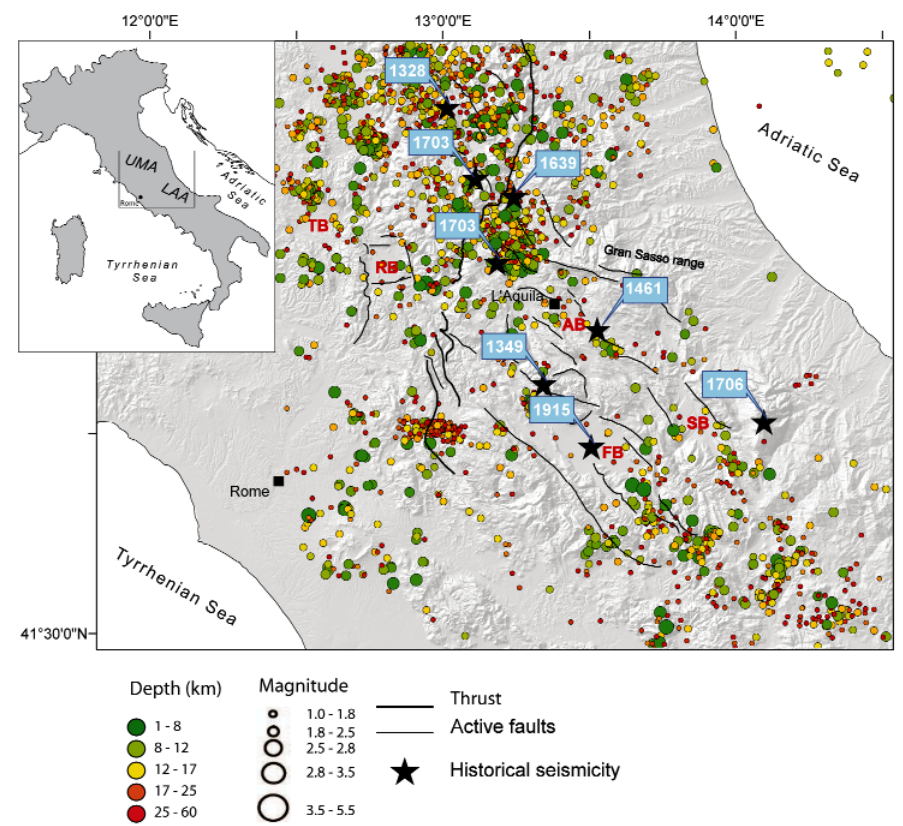
Figure 1. Geological settings of the Umbria-Marche Apennines (UMA) and the Lazio-Abruzzo Apennines (LAA). The main fault systems and intramontane basins are shown (red text): TB, Terni basin; RB, Rieti basin; AB, L'Aquila basin; FB, Fucino basin; SB, Sulmona basin. The instrumental (1978-2008) and historical (I>10) (CPTI04) (http://emidius.mi.ingv.it/CPTI04) seismicity distributions are shown. Inset: Location of the study region within